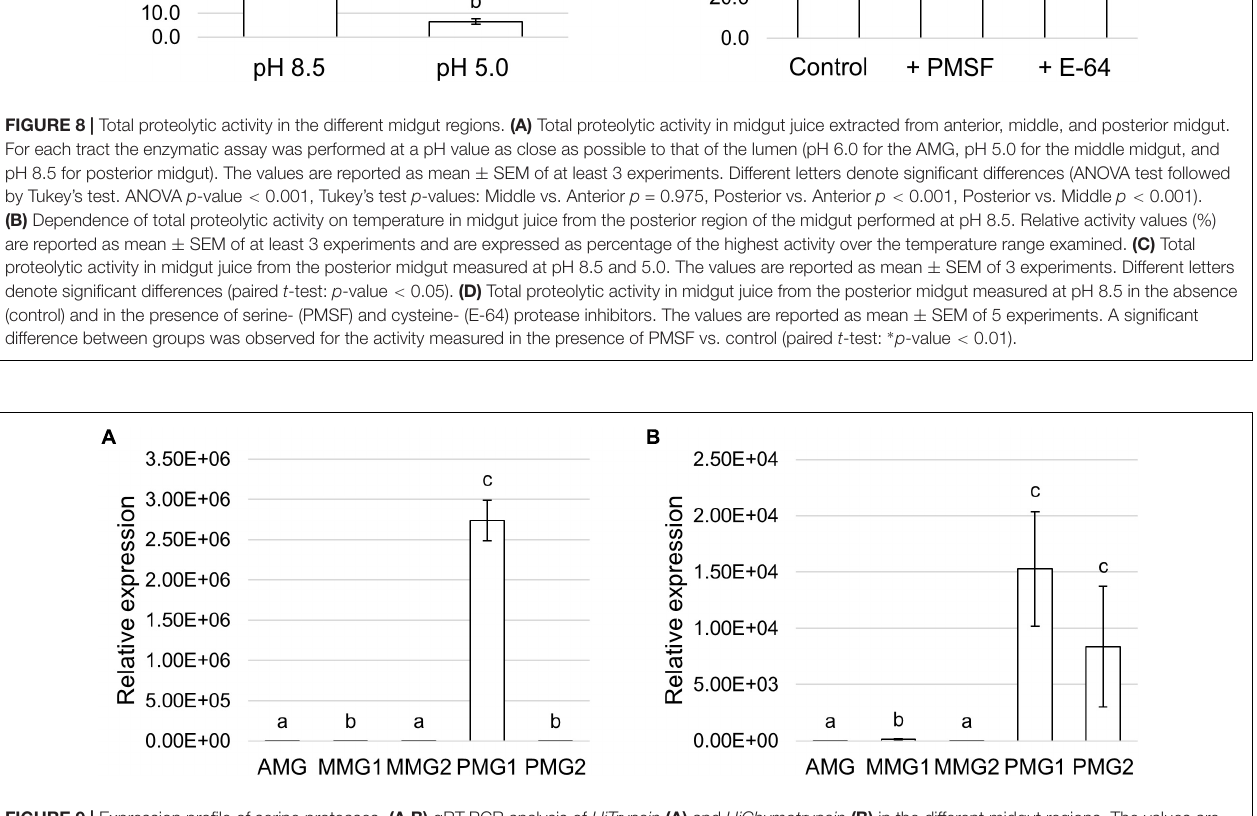
FIGURE 9 | Expression profile of serine proteases. (A,B) qRT-PCR analysis of HiTrypsin (A) and HiChymotrypsin (B) in the different midgut regions. The values are reported as relative expression mean ± SEM of 3 experiments. Different letters denote significant differences: HiTrypsin (ANOVA test followed by Tukey’s test. ANOVA p -value < 0.001, Tukey’s test p -values: AMG vs. MMG1 p < 0.001, AMG vs. MMG2 p = 0.107, AMG vs. PMG1 p < 0.001, AMG vs. PMG2 p < 0.001, MMG1 vs. MMG2 p < 0.05, MMG1 vs. PMG1 p < 0.001, MMG1 vs. PMG2 p = 0.328, MMG2 vs. PMG1 p < 0.001, MMG2 vs. PMG2 p < 0.001, PMG1 vs. PMG2 p < 0.001); HiChymotrypsin (ANOVA test followed by Tukey’s test. ANOVA p -value < 0.001, Tukey’s test p -values: AMG vs. MMG1 p < 0.01, AMG vs. MMG2 p = 0.237, AMG vs. PMG1 p < 0.001, AMG vs. PMG2 p < 0.001, MMG1 vs. MMG2 p < 0.001, MMG1 vs. PMG1 p < 0.01, MMG1 vs. PMG2 p < 0.01, MMG2 vs. PMG1 p < 0.001, MMG2 vs. PMG2 p < 0.001, and PMG1 vs. PMG2 p <